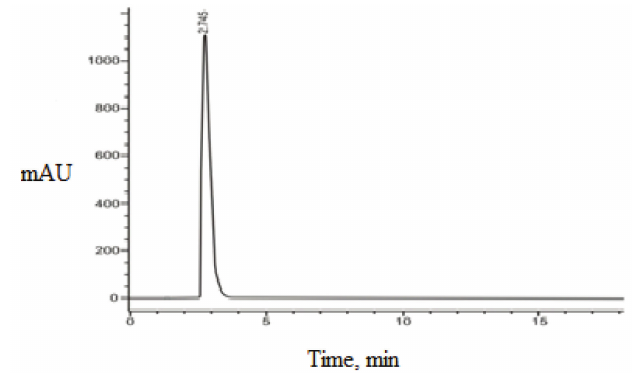
FIGURE 2 - Standard Chromatogram of venlafaxine